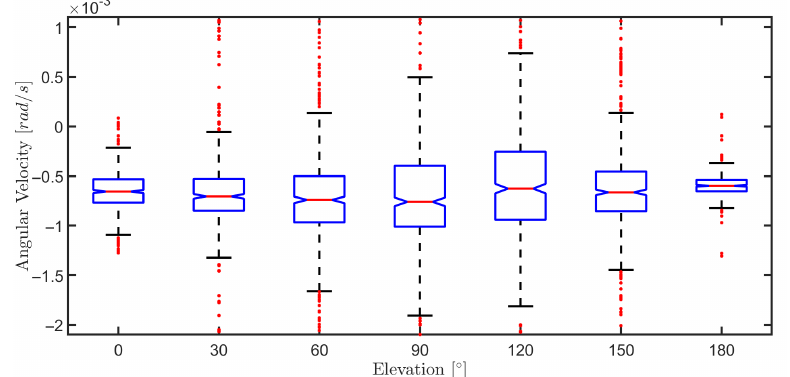
Figure 20. Boxplot of the angular velocities in the elevation variation